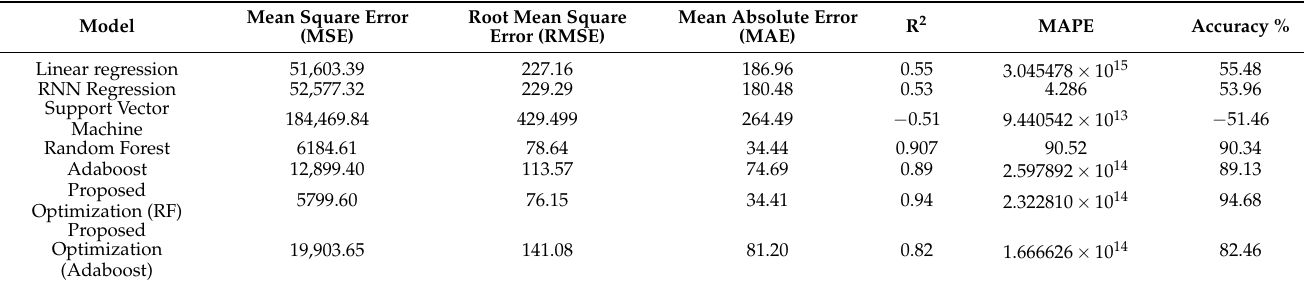
Table 4. Results obtained on Juriquilla, Queretaro dataset for the year 2020.